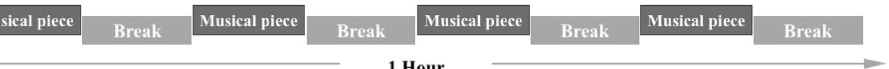
Figure 1. Musical stimulation arrangement. Musical pieces were randomly presented, considering interspersed rest